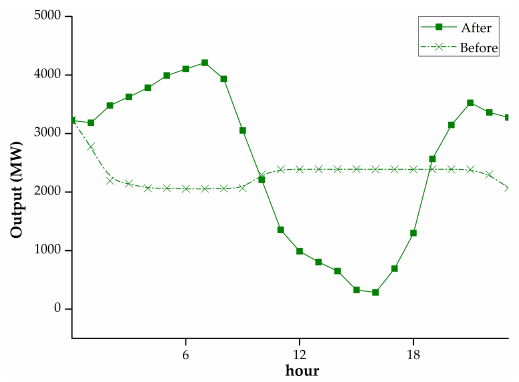
Figure 9. Cascade hydropower station total output of S-SP before, and after, complementary optimization.